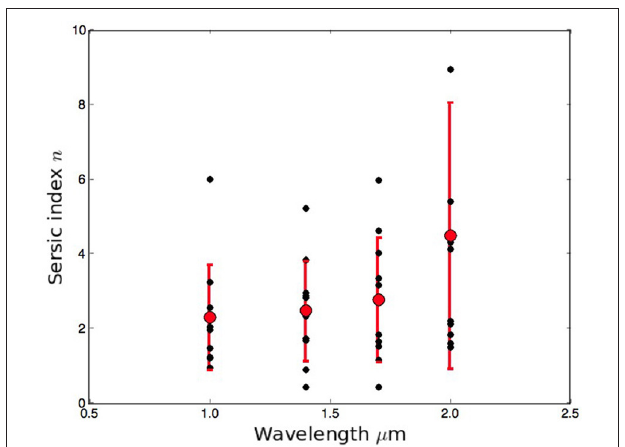
FIGURE 1 | Sérsic indexes ( n ) vs. observed wavelengths. Red symbols indicates the index mean